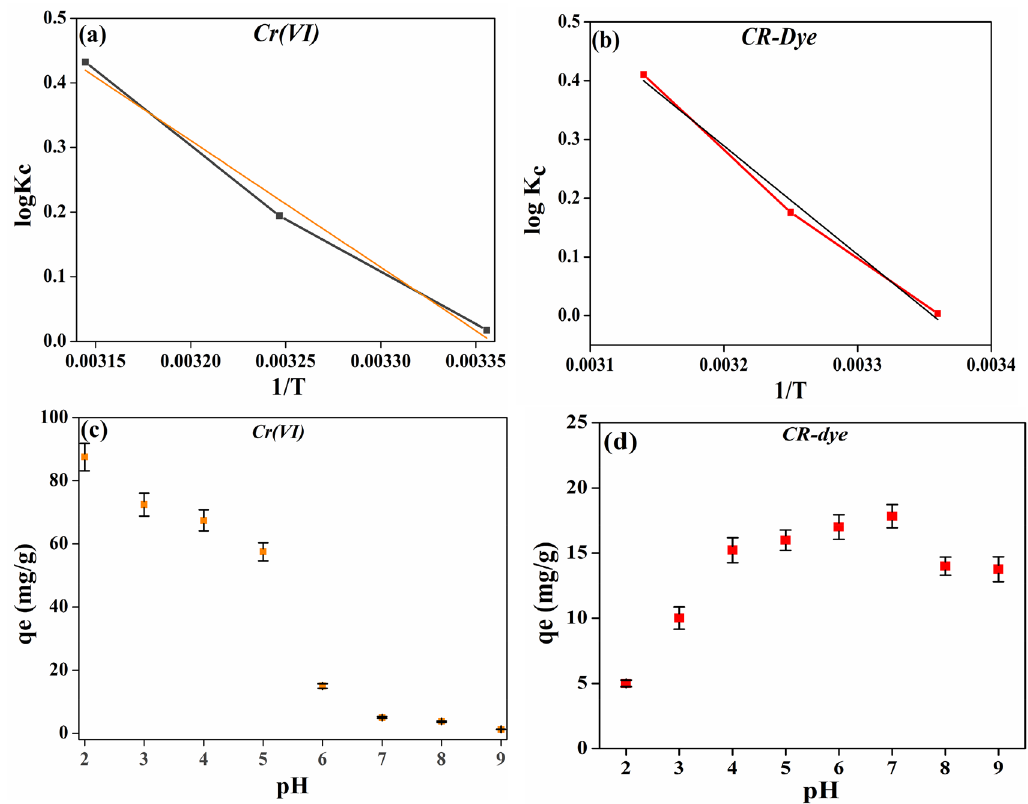
Figure 8. T hermodynamics and pH effects on adsorption. ( a , c ) Cr(VI), and ( b , d ) CR-dye.